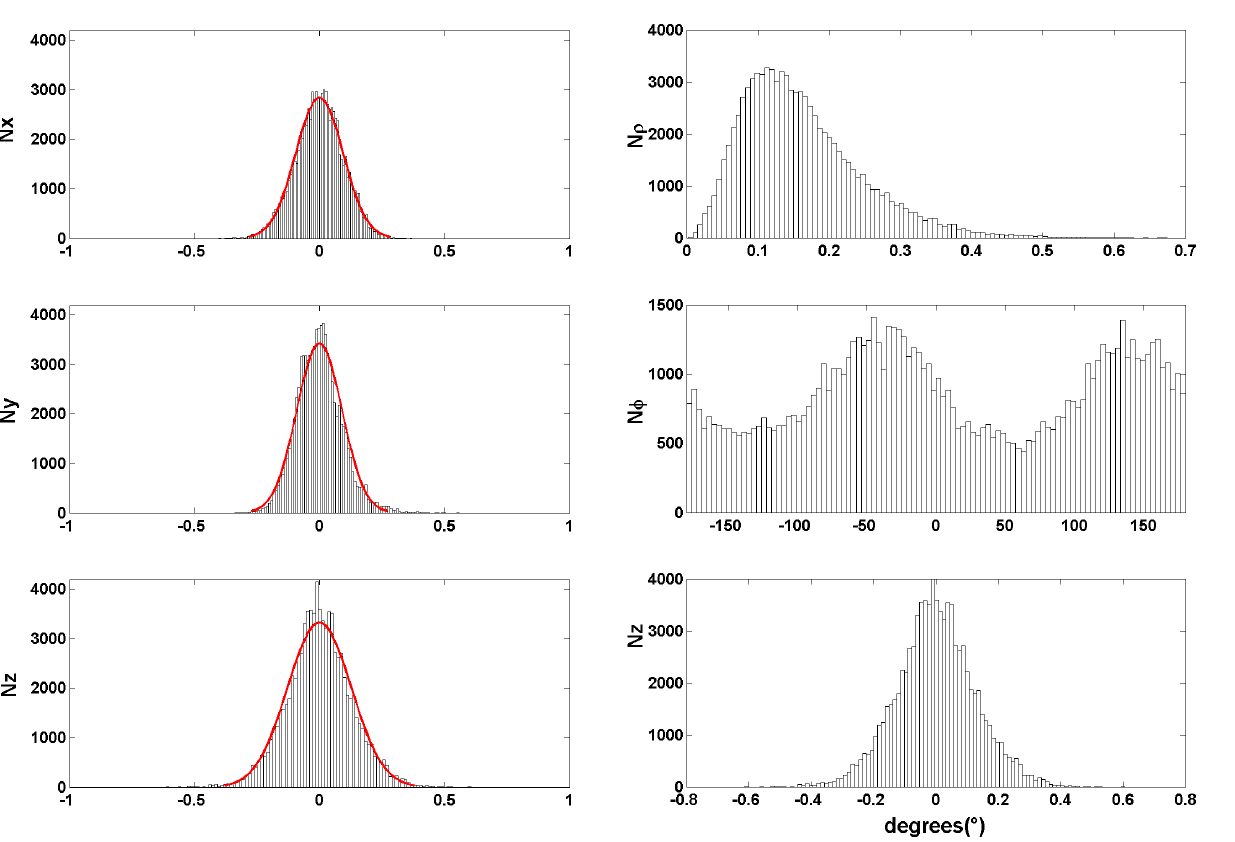
Figure 14. Probality distribution of signal amplitude. Figure 15. Noise distribution in cylindrical coordinates.